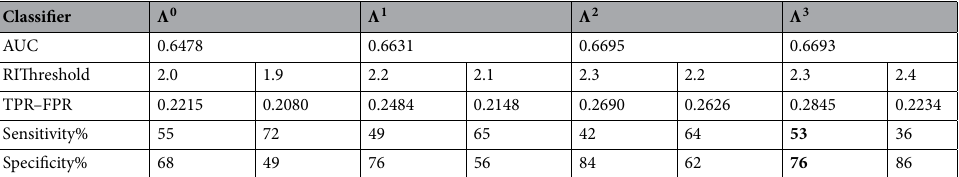
Table 3. Statistical measure of the performance of the classifiers and AUC. The sensitivity and specificity obtained for the best performing classifier-refractive index threshold association is given in